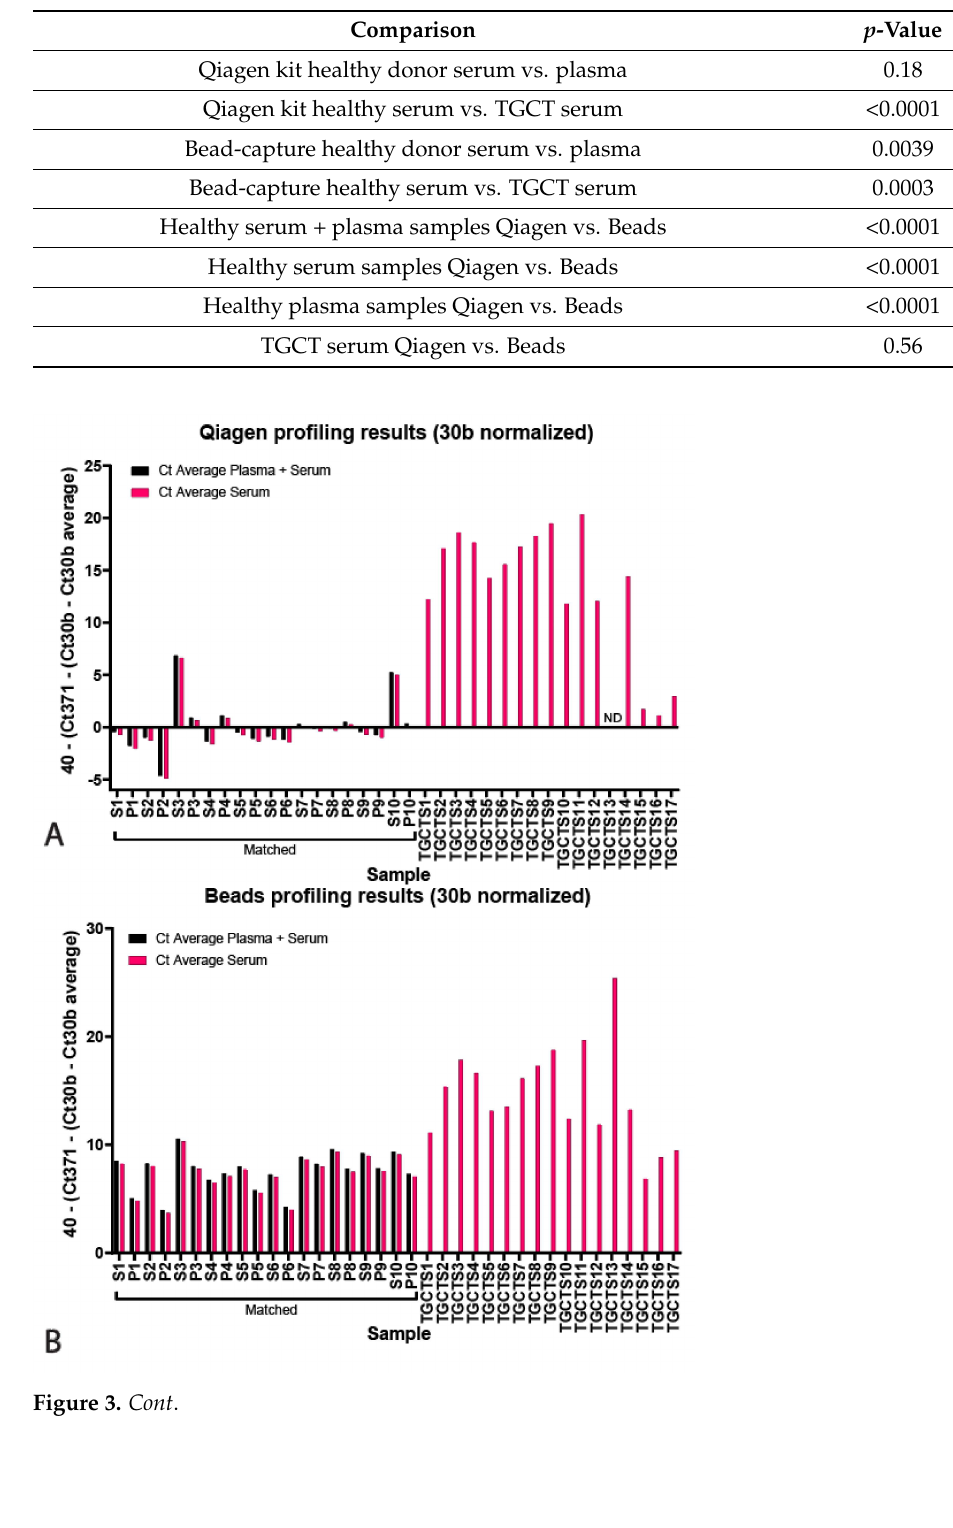
Table 2. p -values of hsa-miR371a-3p detection in healthy control and TGCT patient samples corrected for hsa-miR30b-5p.